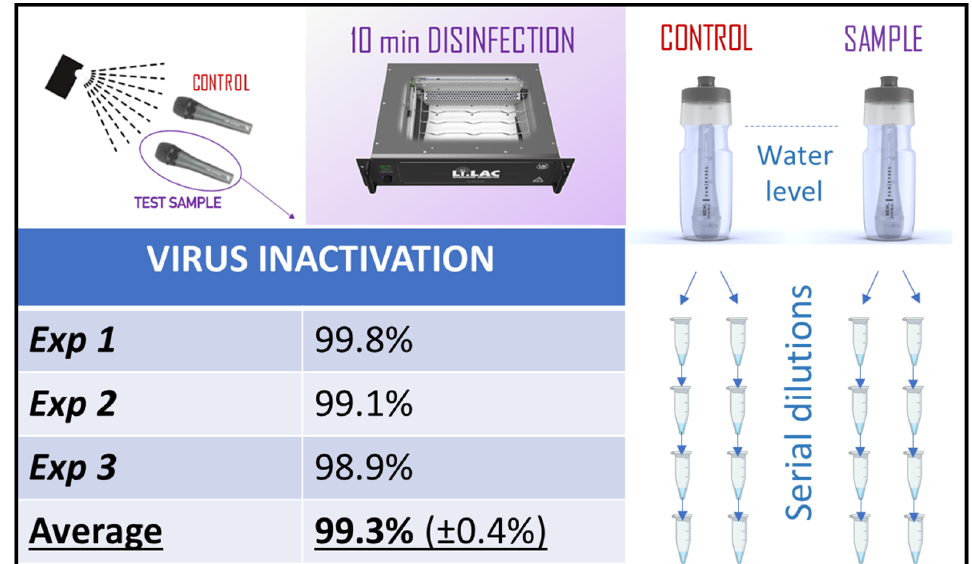
Figure 4. Spray deposition of bacteriophage M13 on complete microphones, which were subsequently subjected to disinfection by using UV-C. Extraction of M13 was performed by full submersion of the microphones in water combined with shaking. The amounts of M13 extracted from infected and disinfected microphones were compared, and the total reduction of active virus was determined.